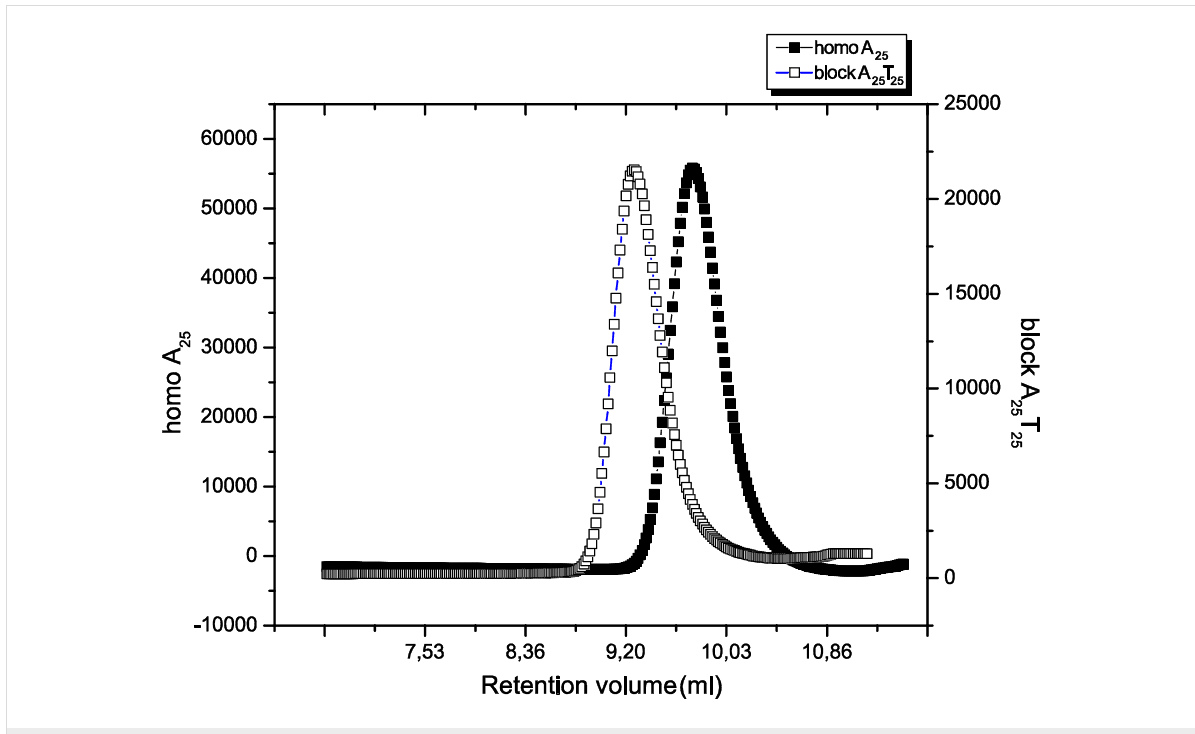
Figure 7: GPC trace of the block copolymer A 25 T 25 synthesized with catalyst U3 .